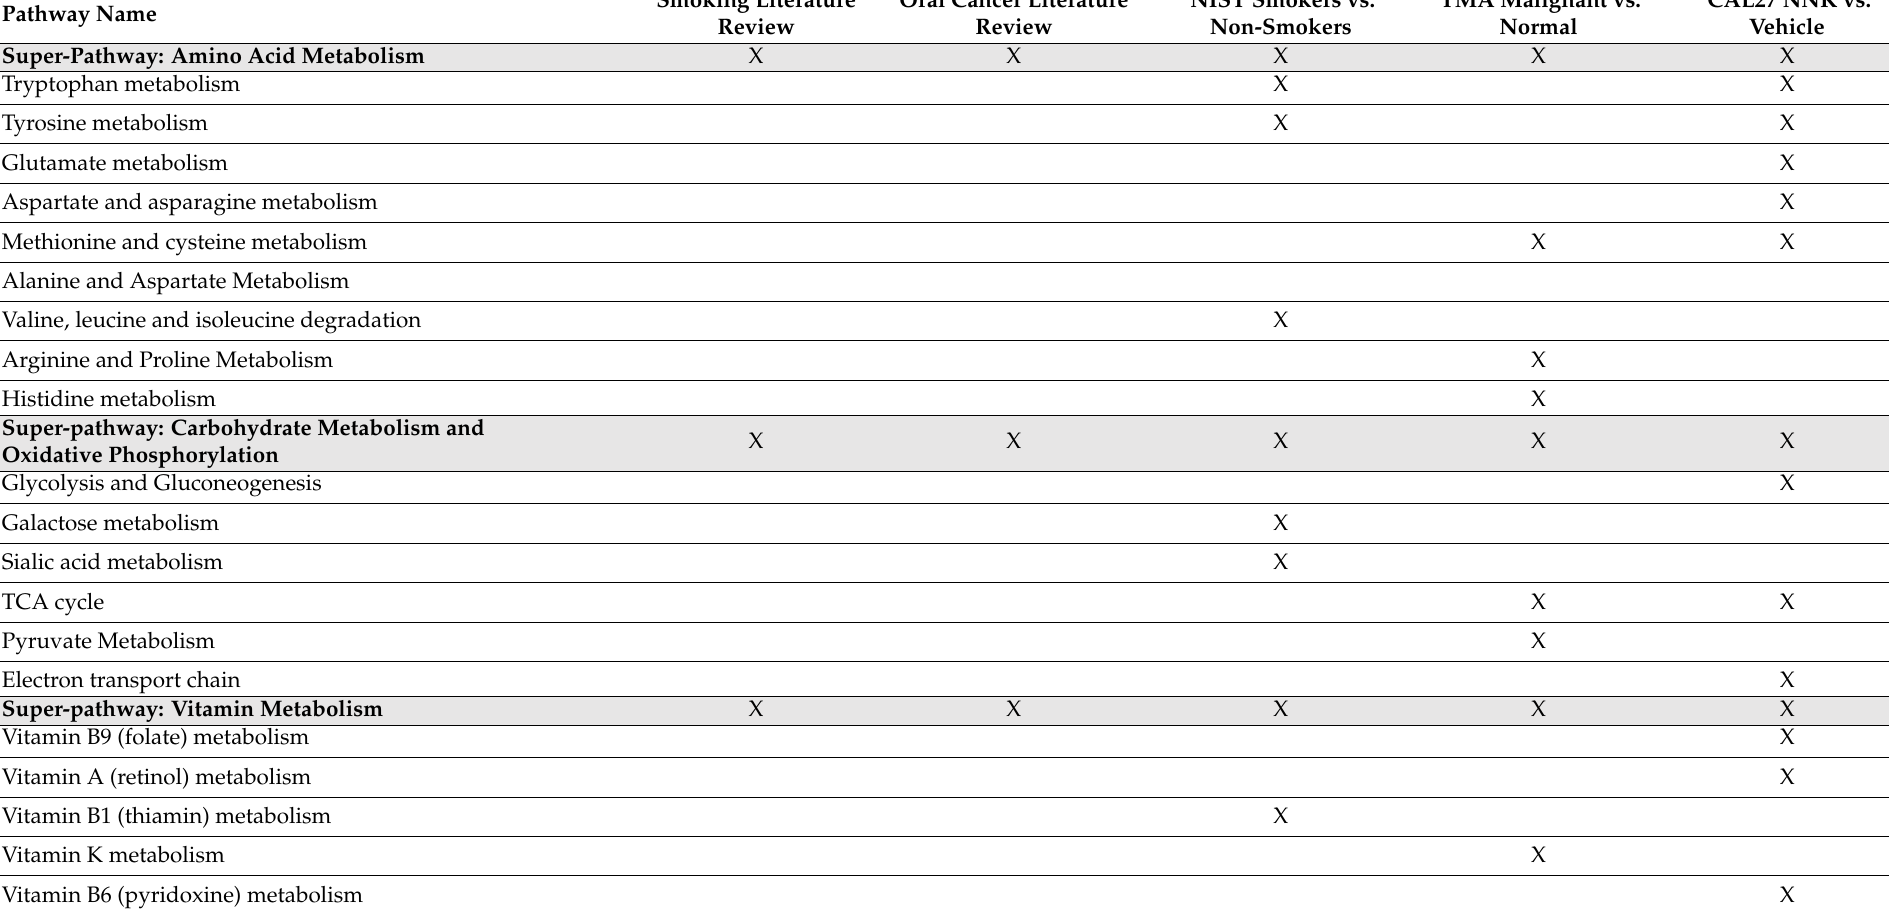
Table 9. Summary of common metabolic alterations between literature reviews and